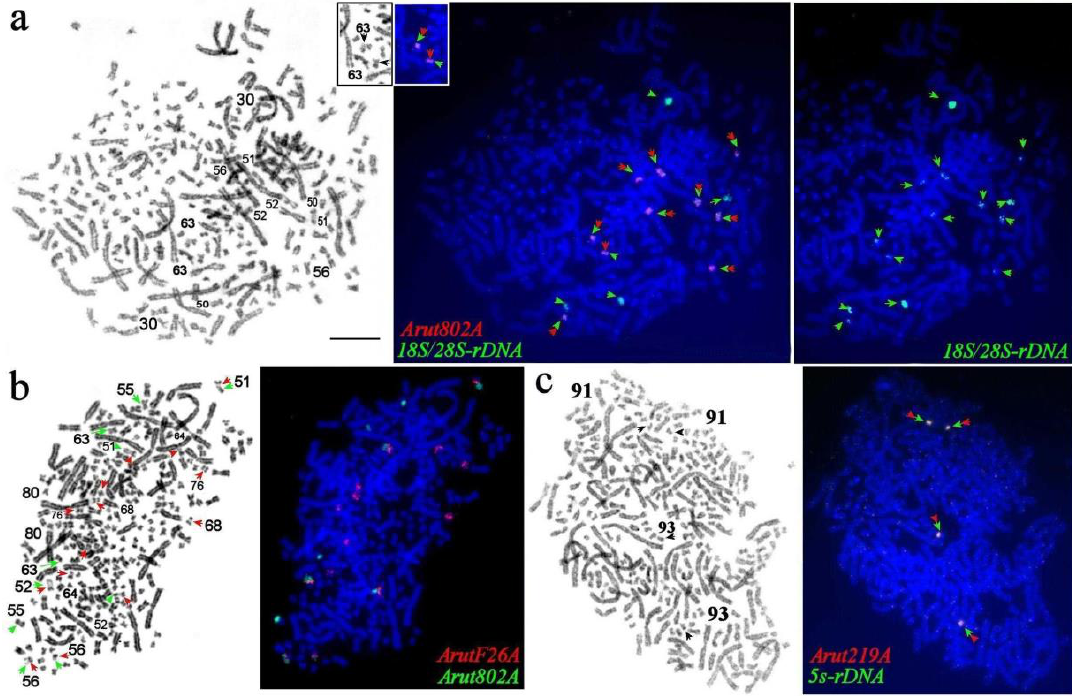
Figure 8. FISH of repetitive and microdissection-derived painting probes (right) on GTG-banded metaphase plates (left) of the Siberian sturgeon ( a–с ). ( a ) 18S/28S rDNA (green) and Arut802A (red); ( b ) Arut802A (green) and ArutF26A (red); ( c) 5S rDNA (green) and Arut219A (red). Chromosomes with signals are marked and numbered; double arrows indicate chromosomes with colocalized probes. The scale bar is 10 µm.